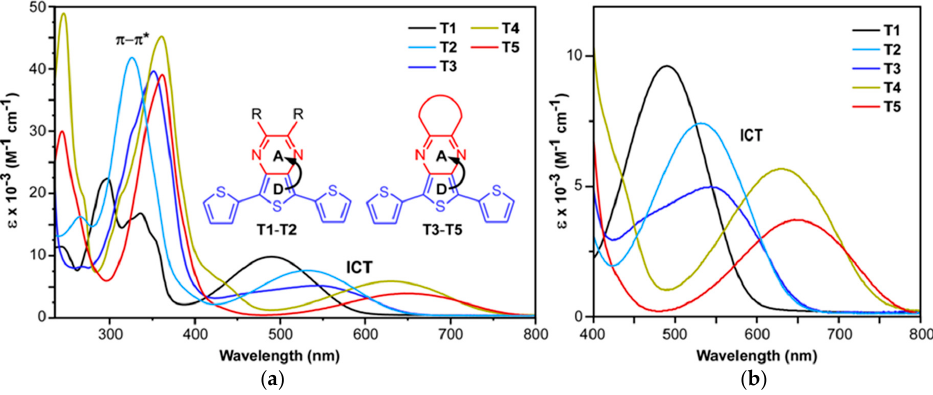
Figure 5. ( a ) UV-visibile spectra of TP-based terthienyls T3 – T5 ; ( b ) visible region highlighting the ICT transitions of T1 – T5 .